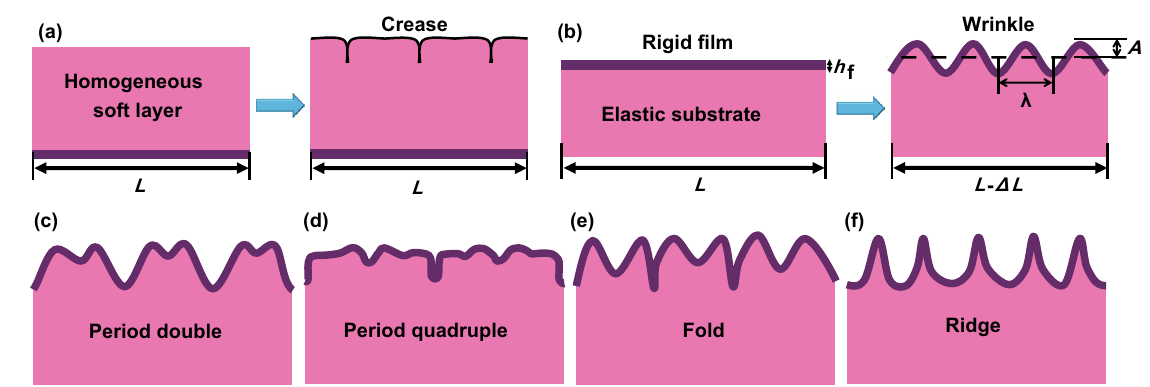
Fig. 2 a Schematic of crease formation on the surface of a homogeneous soft layer supported on a rigid substrate. b Schematic of wrinkle for- mation in a typical bilayer system composed of a rigid film on an elastic substrate. h f is the film thickness, A and λ represent the amplitude and wavelength of the wrinkle, respectively. c – f Schematic of several typical morphological instability: c period double, d period quadruple, e fold,